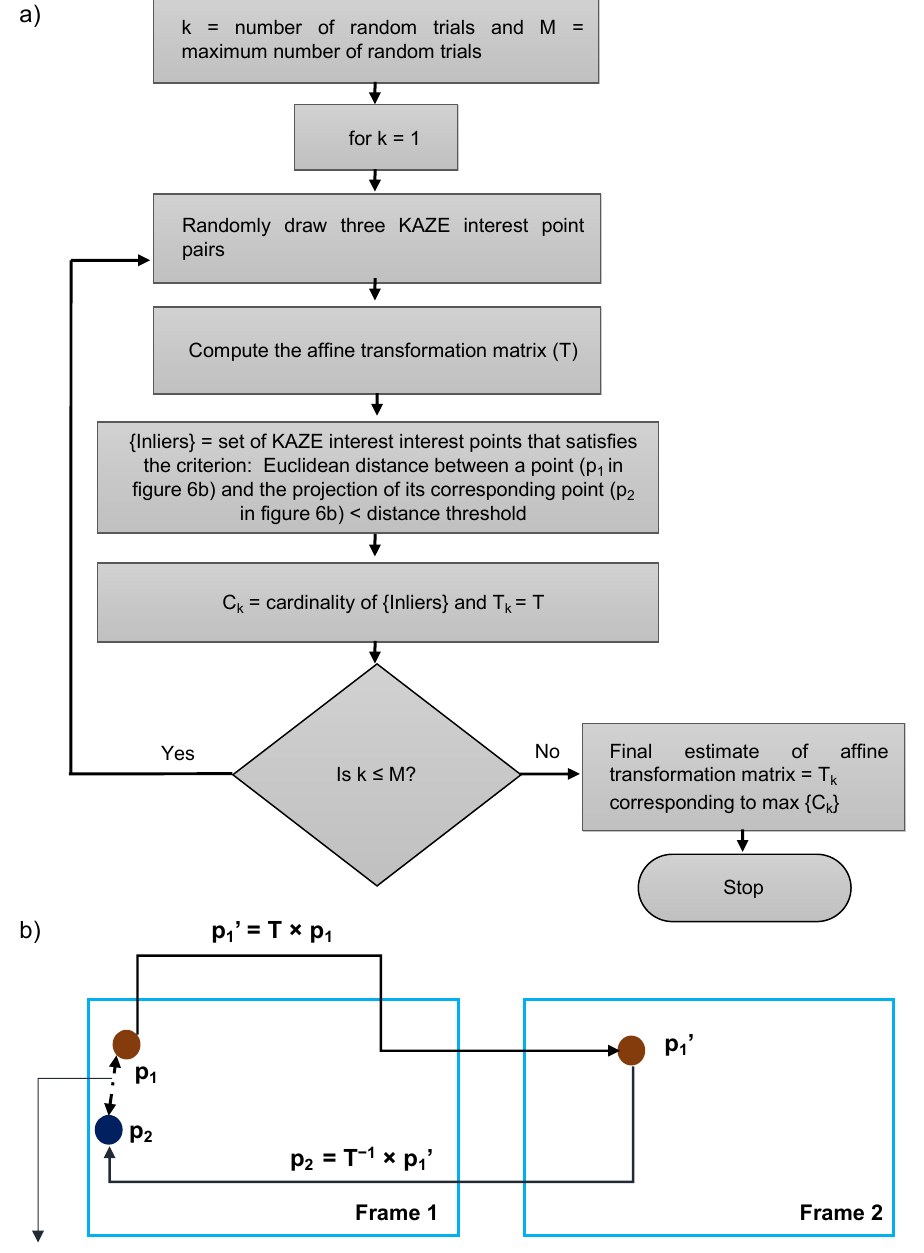
Figure 6. ( a ) Flow diagram for estimation of affine transformation matrix using M-SAC algorithm in estimaGeometricTransform2D MATLAB function ( b ) Illustration of maximum distance thresh- old.